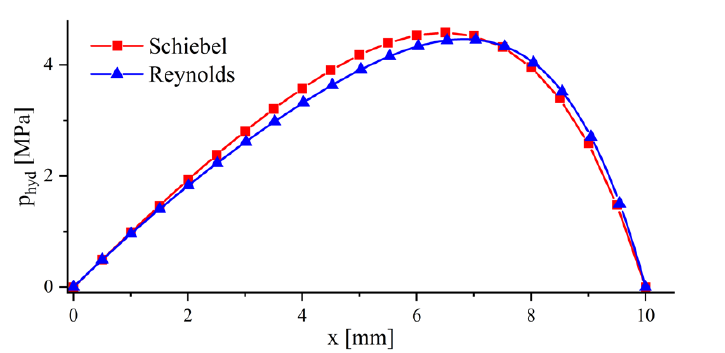
Figure 6 . Centered hydrodynamic pressure distribution of the smooth lubrication